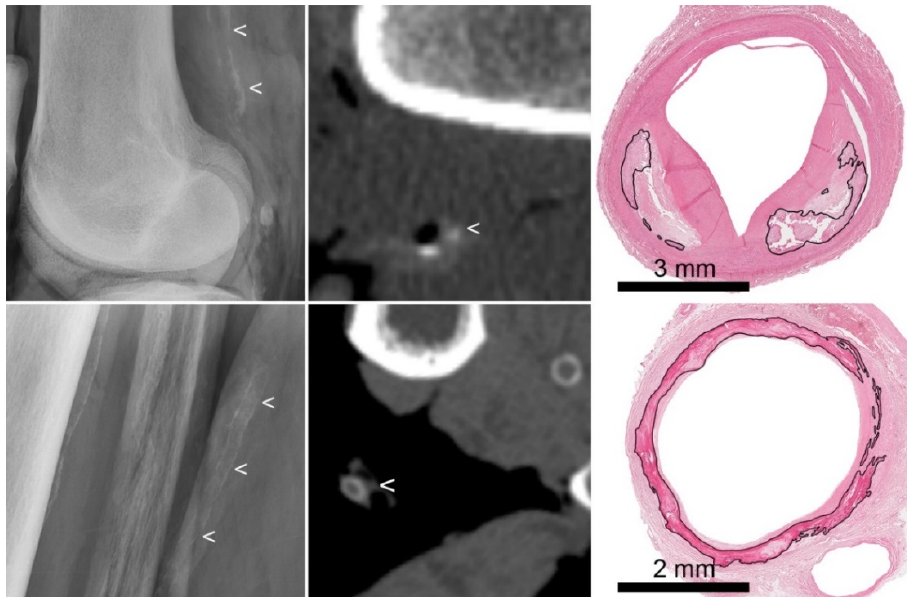
Figure 1. Examples of intimal and medial calcification on radiograph and CT. ( Top row ): atherosclerotic intimal calcifications. From left to right: radiograph (showing irregularly distributed thick calcifications (<)), CT (showing thick dots of calcification (<)), and histology (showing calcifications (marked) located in an atherosclerotic plaque). ( Bottom row ): medial calcifications. From left to right: radiograph (showing regularly distributed thin calcifications along the vascular wall (<)), CT (showing circular thin calcifications (<)), and histology (showing circular calcifications (marked) involving the internal elastic lamina, in the absence of atherosclerosis). Table 1. Inter-method agreement for both radiograph and CT for the experienced observer. Table 2. Inter-observer agreement for